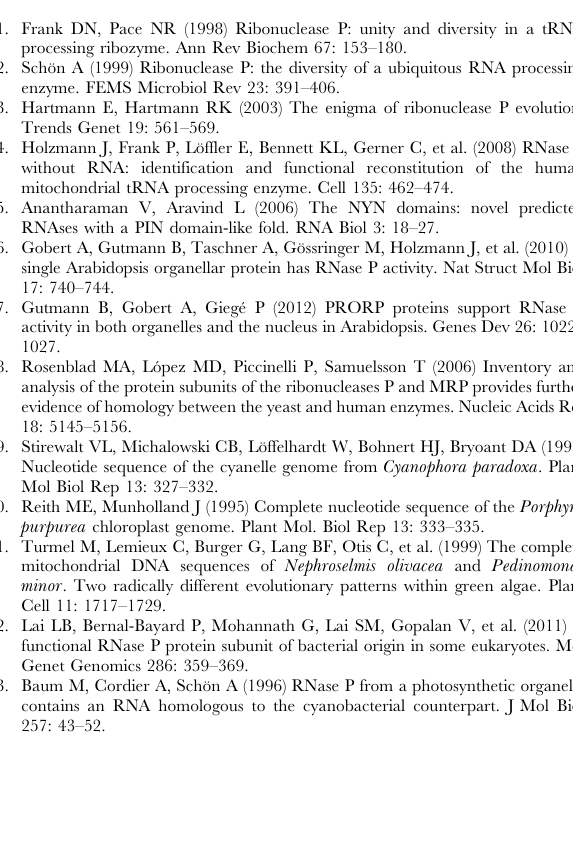
Table S1 List of PRORP and PRORP-like proteins from various organisms. Table S2 Oligonucleotides used in this